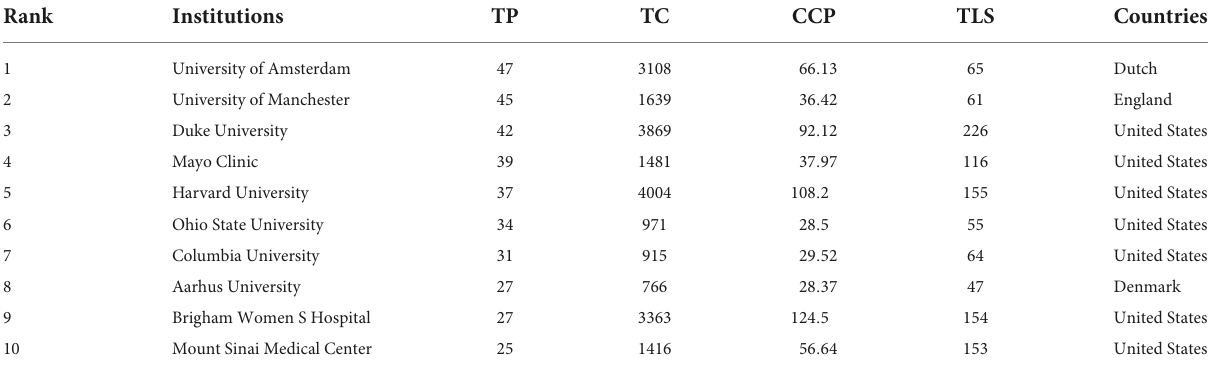
TABLE 2 The top 10 productive institutions of sick sinus syndrome.